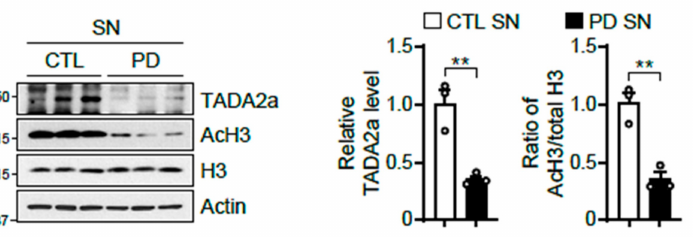
Figure 6. Reduction in TADA2a levels and histone H3 acetylation in the SN of patients with PD. Im- munoblot analysis of TADA2a, AcH3, and histone H3 in the SN of the age-matched control (CTL) and patients with PD normalized to β -actin. Quantification of the level of TADA2a normalized to β -actin (middle panel) and the ratio of AcH3/total H3 (right panel), n = 3 per group. Data = mean ± SEM. Statistical significance was determined using an unpaired, 2-tailed Student’s t -test, ** p <